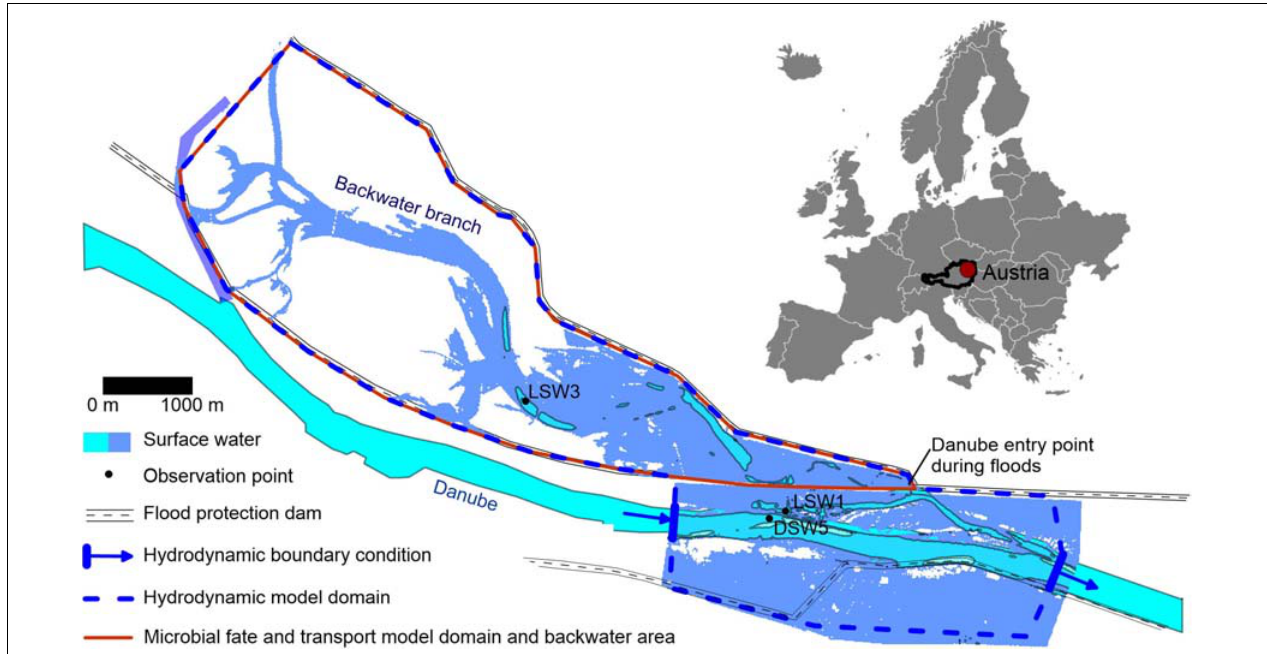
FIGURE 1 | Study area with observation points DSW5 (Danube), LSW1 (affected by Danube discharge and inundation) and LSW 3 (affected by rainfall-release from fecal deposits) (Frick et al., 2020), QMRAcatch and hydrodynamic model domain; the surface water area simulated during the peak of the flood event in January 2011 is indicated in blue.